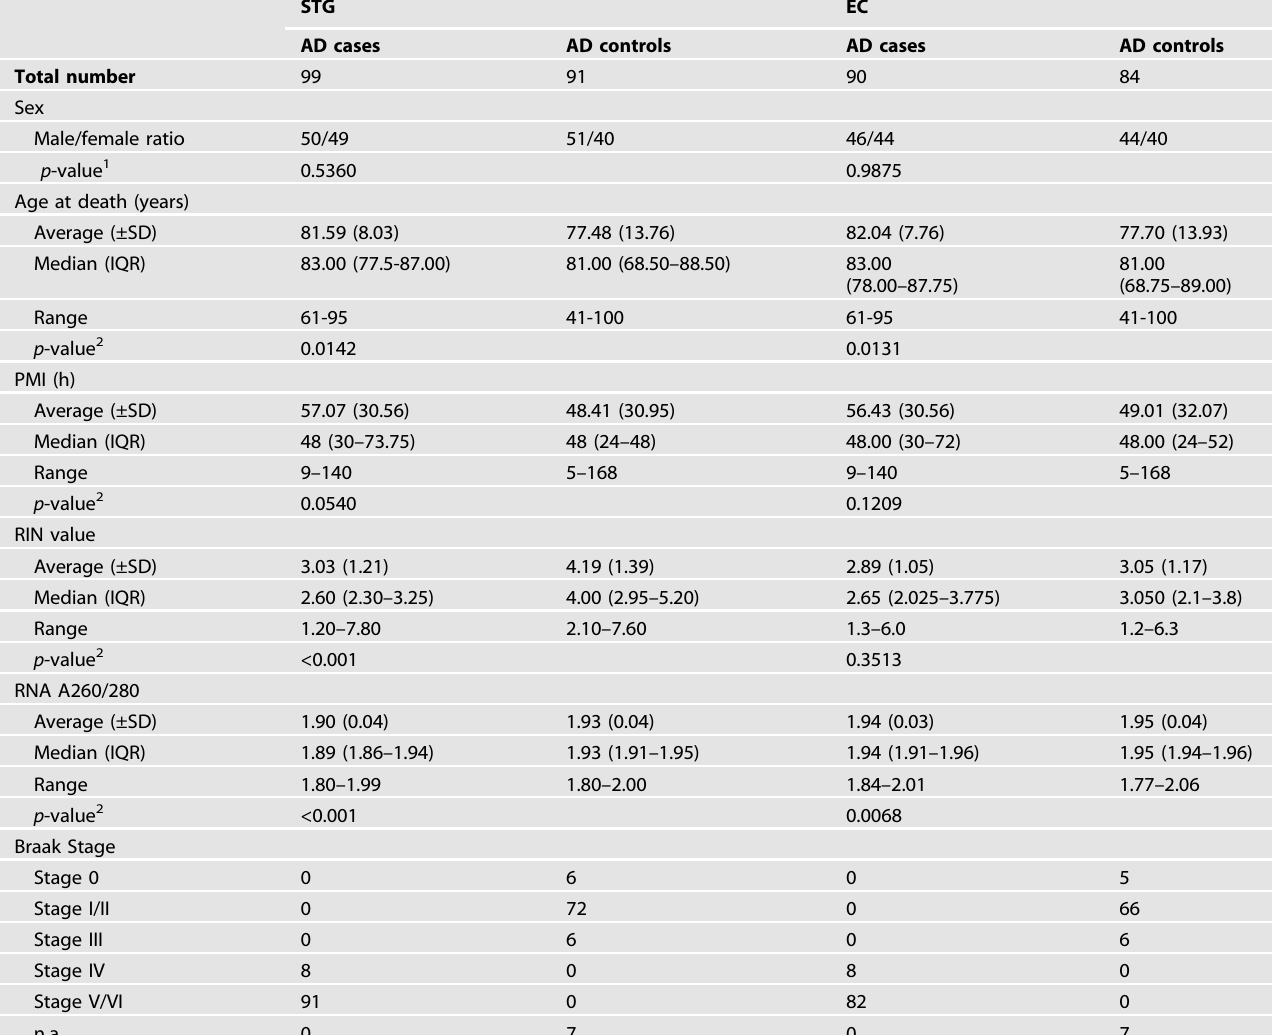
Table 1. Overview of the brain samples analyzed in this